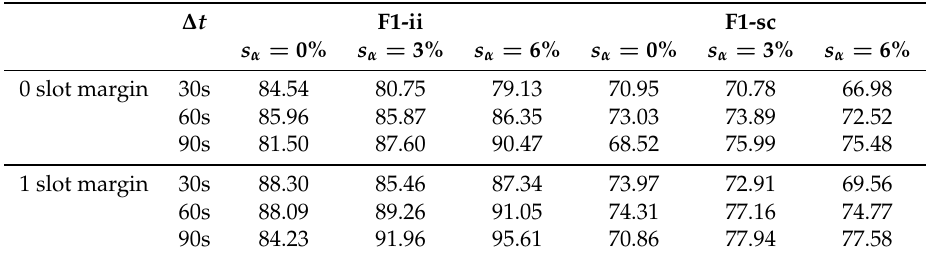
Table 1. Global results.